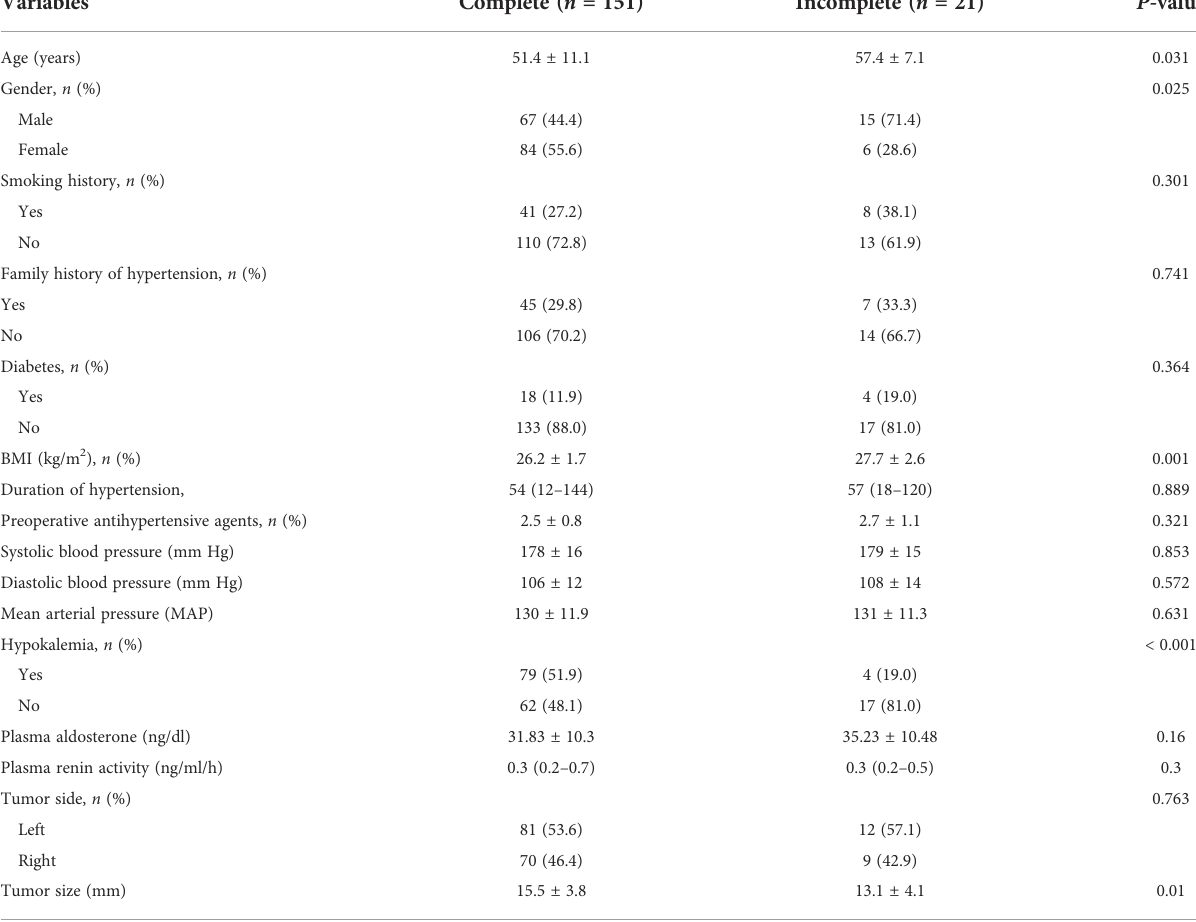
TABLE 2 Comparison of clinical data between the patients with and without complete biochemical success.